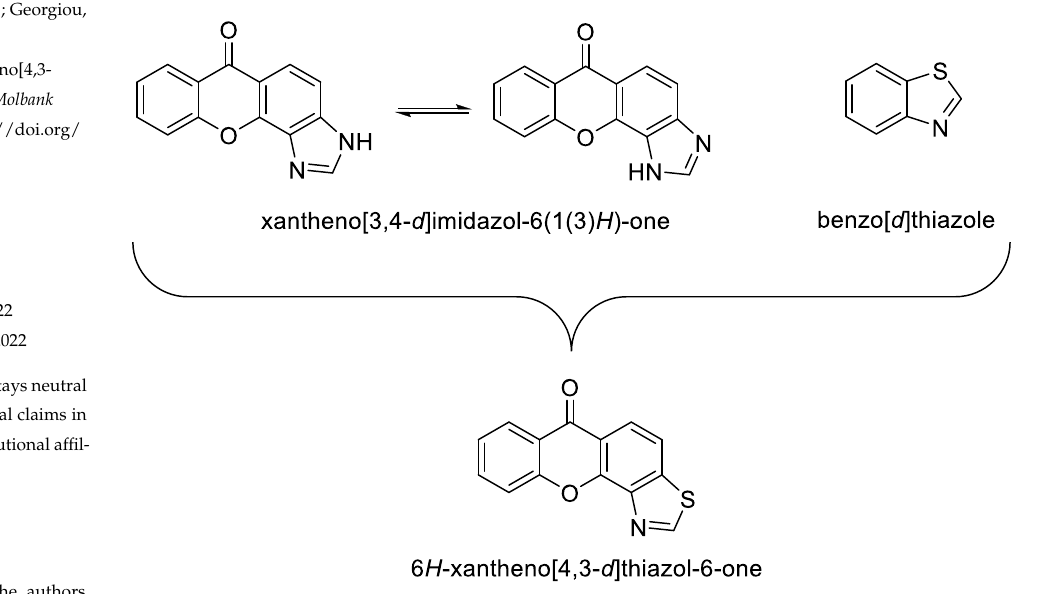
Figure 1. Benzothiazole- and imidazole-fused xanthones of interest. Tautomerism of xantheno[3,4- d]imidazol-6(1(3) H )-one.